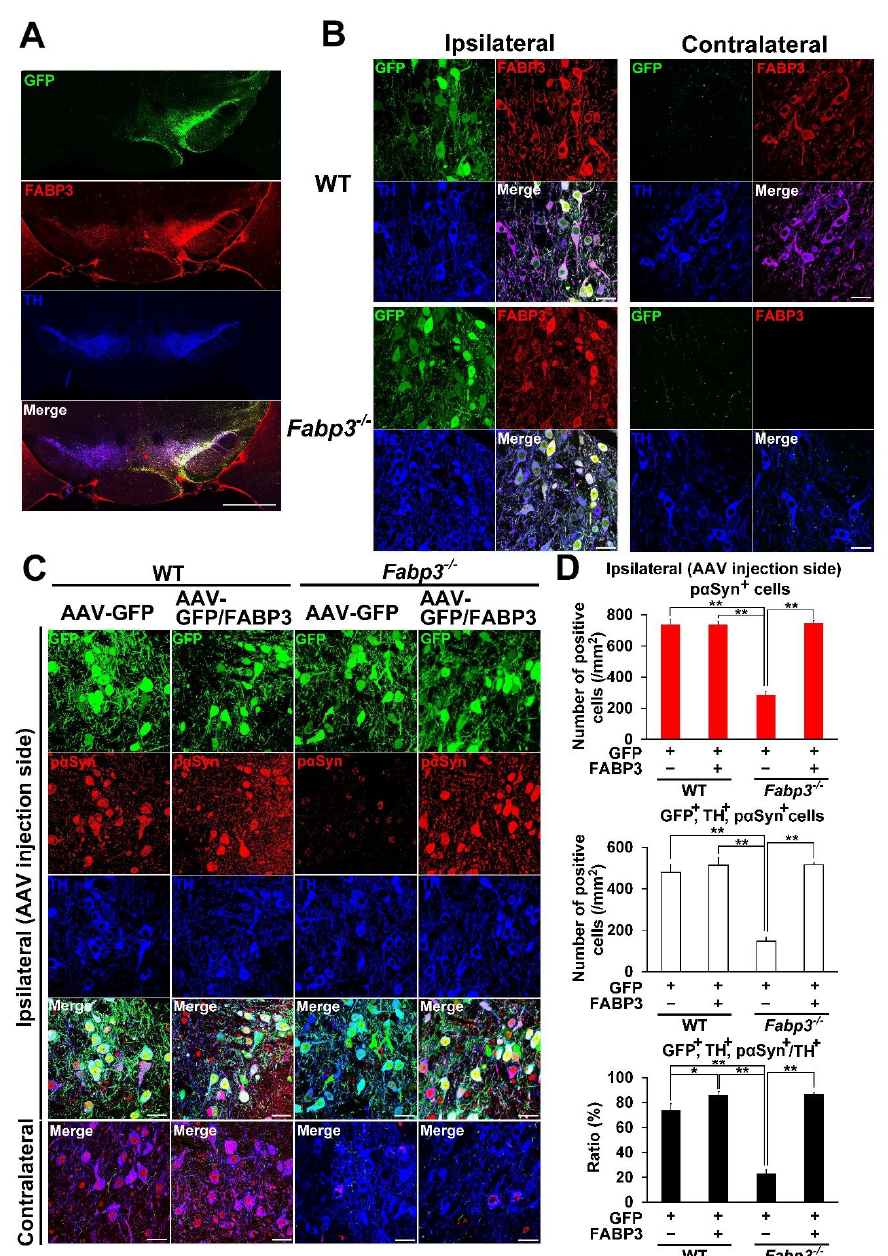
Figure 2. Overexpression of FABP3 using AAV antagonizes the decrease in the immunoreactivity of phosphorylated α -Syn in mouse α -Syn PFF-injected Fabp3 − / − mice. ( A ) Representative images of GFP (green), FABP3 (red), and TH (blue) in the SNpc in AAV-GFP / FABP3 WT mice. Scale bars: 1 mm. ( B ) Representative high magnification images of GFP (green), FABP3 (red), and TH (blue) in both the ipsilateral and contralateral SNpc in AAV-GFP / FABP3 WT and Fabp3 − / − mice. Scale bars: 30 µ m. ( C ) Representative images of GFP (green), phosphorylated α -Syn (Ser-129) (red), and TH (blue) in the SNpc in AAV-GFP or GFP / FABP3 WT and Fabp3 − / − mice. Scale bars: 30 µ m. ( D ) Number of phosphorylated α -Syn-positive and triple (GFP-, TH-, and phosphorylated α -Syn)-positive cells was analyzed among all animal groups. The decreased ratio of triple- / TH-positive cells relative to TH-positive cells in AAV-GFP Fabp3 − / − mice was reversed in AAV-GFP / FABP3 Fabp3 − / − mice ( n = 6 per group). Error bars represent standard error of the mean (SEM). * p < 0.05, ** p < 0.01 denotes significance between groups. KO: Fabp3 − / − mice, p α Syn: phosphorylated α -Syn, Veh: vehicle injection, WT: wild-type